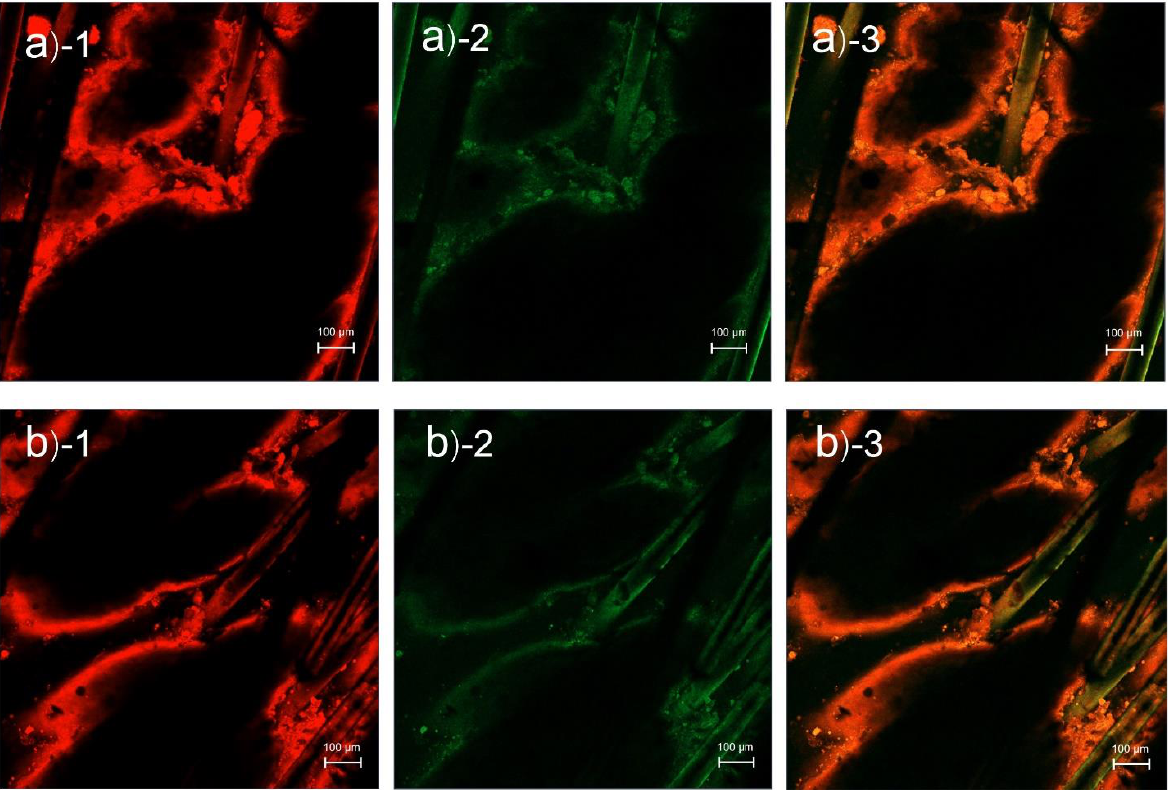
Figure 2. CLSM images (top view) of pig skin treated with rhodamine B base-loaded NBD-PE probed microemulsions from different areas: ( a , b ) at 2 h; (1) red fluorescence from rhodamine B base, (2) green fluorescence from NBD-PE, and (3) merged image of (1) and (2). The scale bar represents 100 µm.